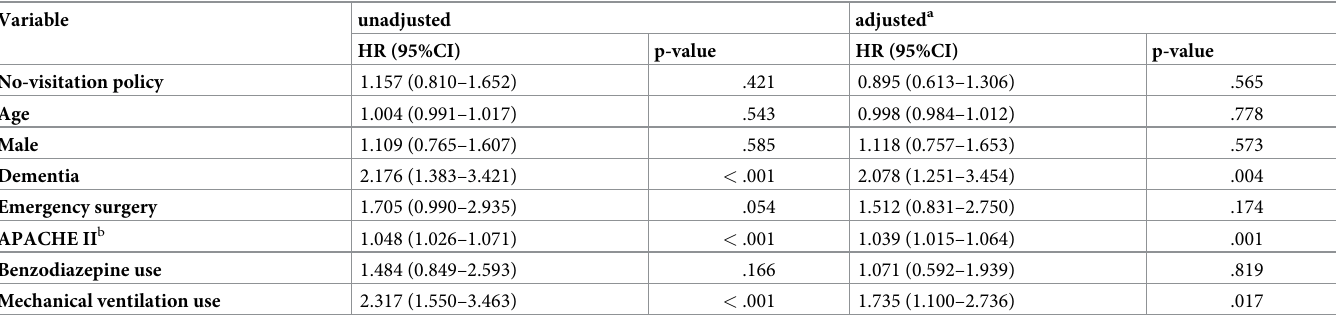
Table 2. Estimates of the hazard ratios of variables on development of delirium in the Cox proportional-hazards